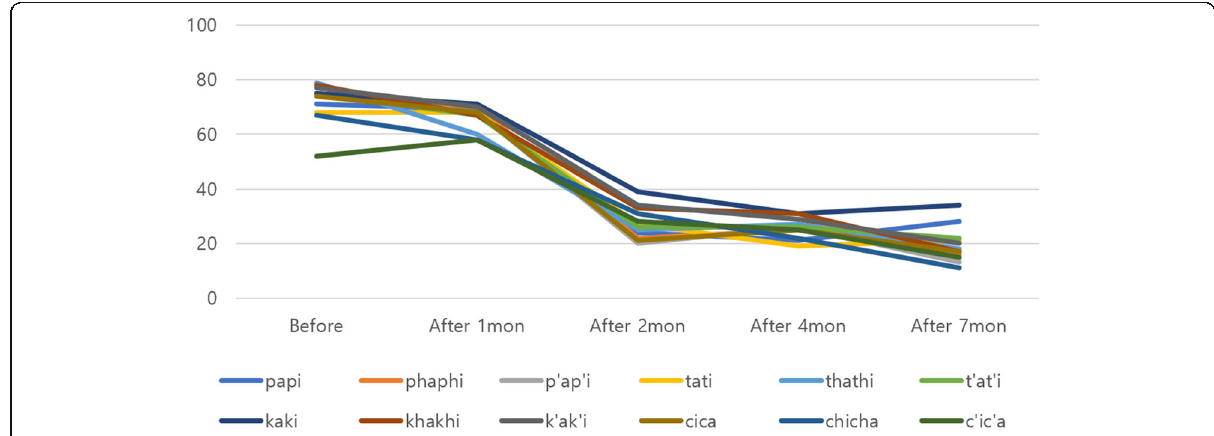
Fig. 5 Evaluation of hypernasality (syllable repetition). Measurements of nasal emission energy in syllable repetition using nasometer.